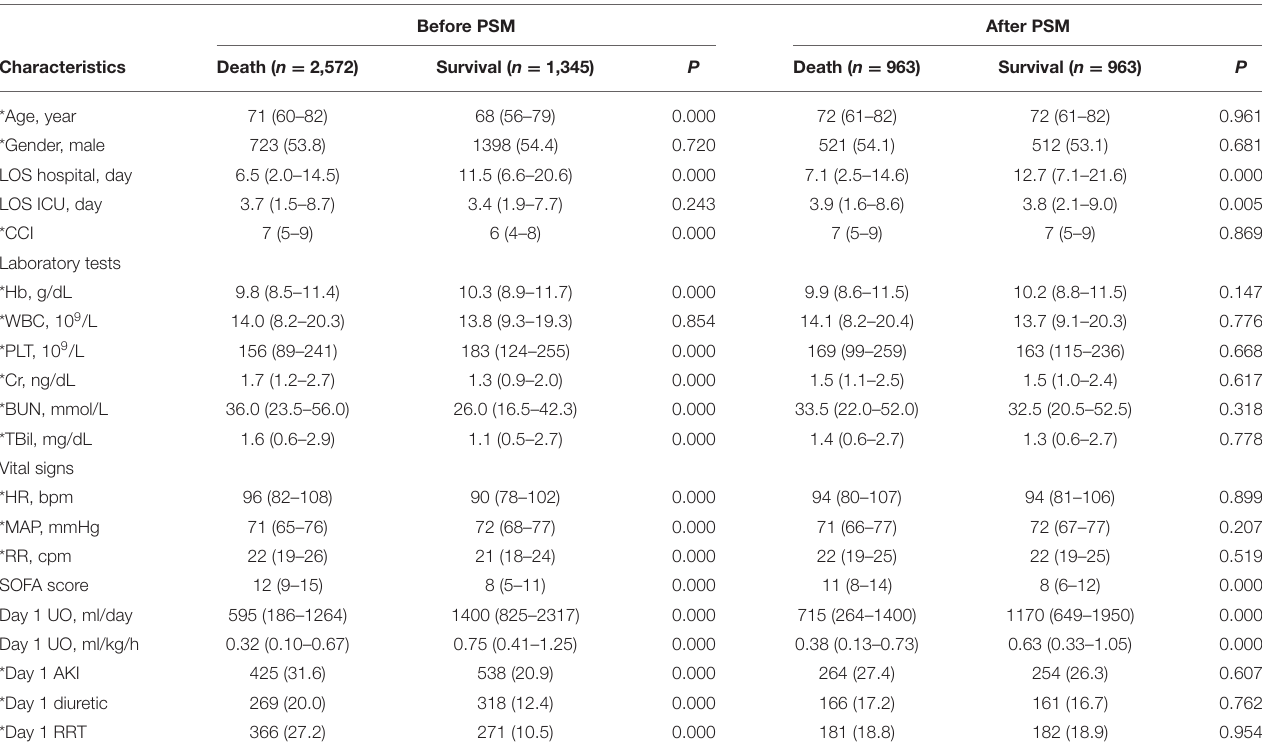
TABLE 1 | Demographic and clinical characteristics of the study population.